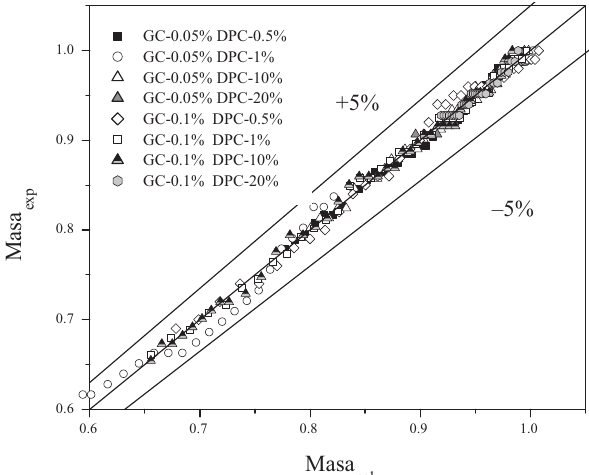
0.0 Fig. 9. Correlation between experimental values (massexp) and calculated (masscal) by means of the Hill equation for the first